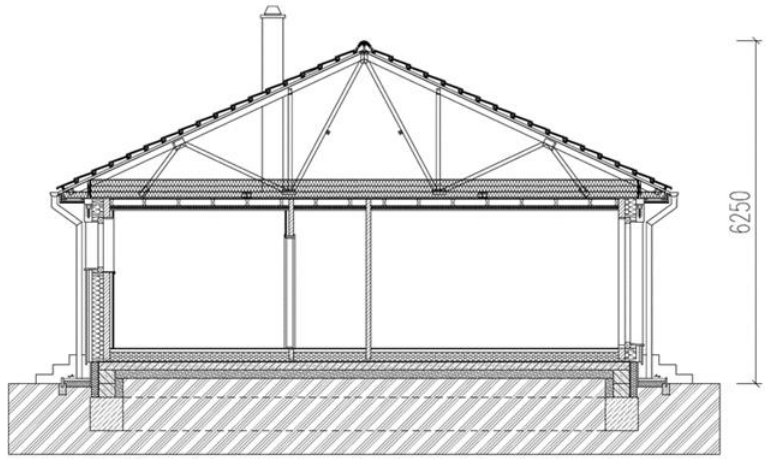
Figure 3. Cross-section of the construction.